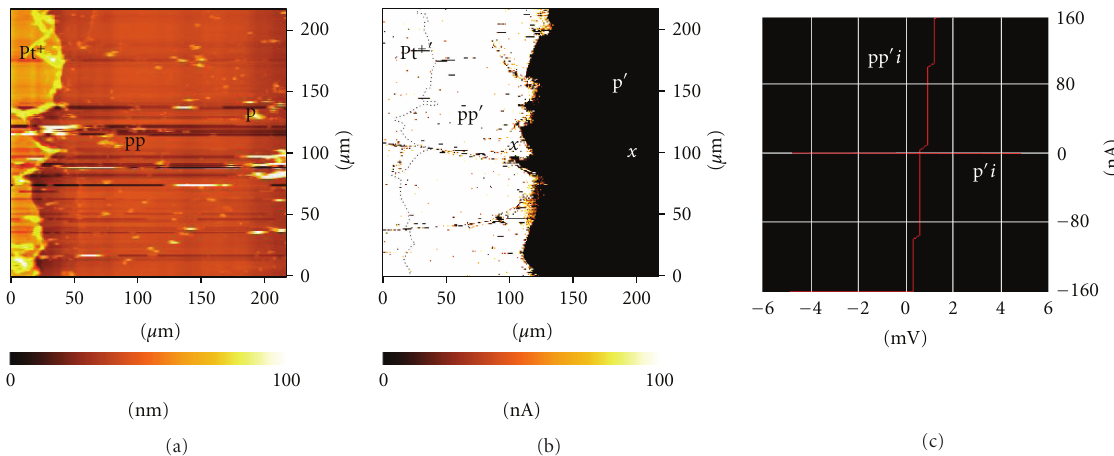
Figure 6: A topographical image (a), a current image (b), and I-V curves (c) simultaneously obtained at the same position corresponding to the positions B in Figure 2(b). Wherein portions pp and pp (cid:2) are polymerized layer and portions p and p (cid:2) are unpolymerized layer of the PNN monomolecular layer, and regions Pt + and Pt + (cid:2) are Pt electrodes. The I-V curves ppi and pi were obtained using the AFM tip covered with Au at the black and white cross-mark in (b),